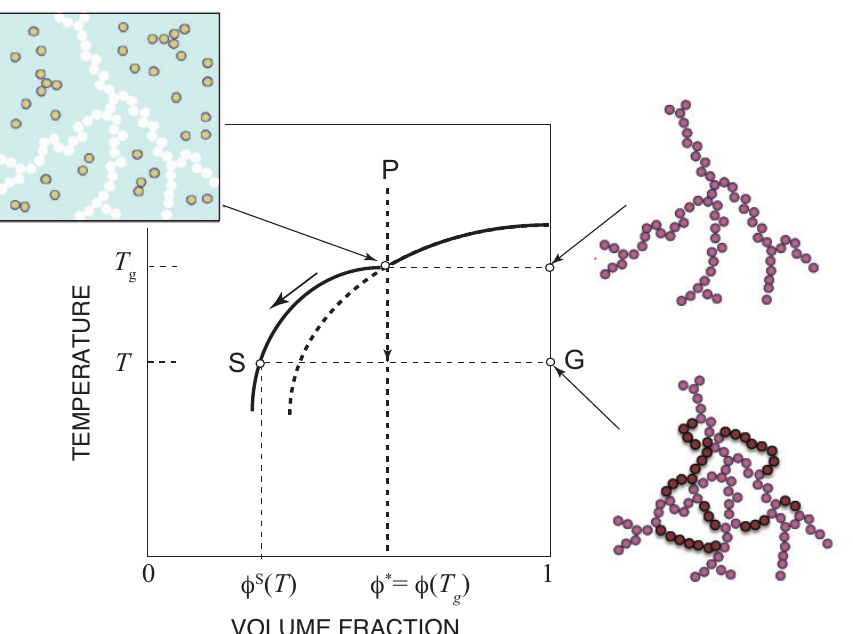
Figure 4. Sol–gel equilibrium in Flory’s post-gel treatment shown on the temperature–concentration plane. By cooling, the concentration of the sol deviates from the sol–gel transition line to lower concentration region because the concentration of the sol part becomes lower than the critical value as gelation proceeds. The gel parts contains